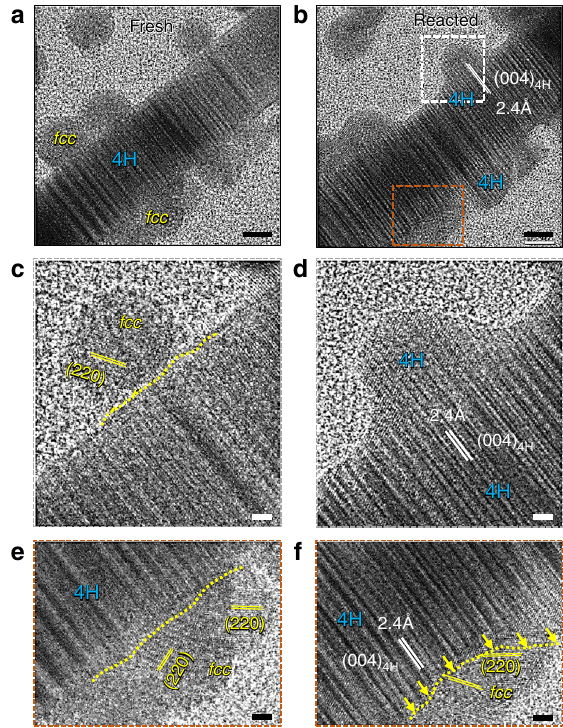
Fig. 3 Phase transformation details of the initial and the fi nal states. a HRTEM showing the original fresh ( a , c , e ) and reacted ( b , d , f ) sample of the same region. The yellow lines in c , e , f labels the boundary between 4H and fcc phase; the yellow arrows in f labels the propagation direction of the phase conversion process; please note that panel c , d ; e , f compares the initial and intermediate state of the phase transformation process at the atomic scale. (the scale bar in a , b is 5 nm and the scale bar in c – f is 1